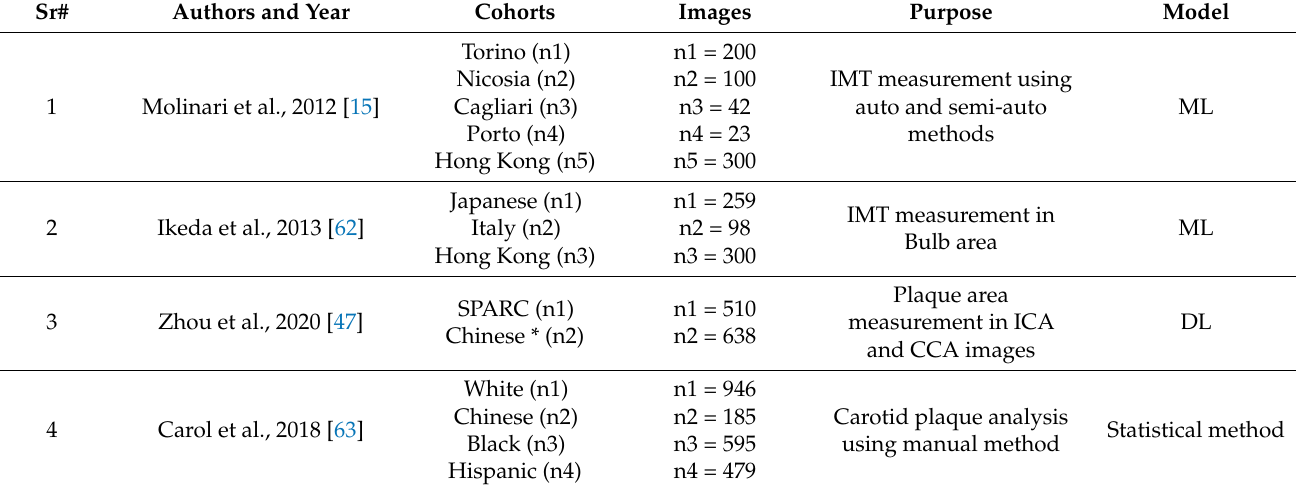
Table 5. Benchmarking table showing multiethnic database studies for atherosclerotic plaque